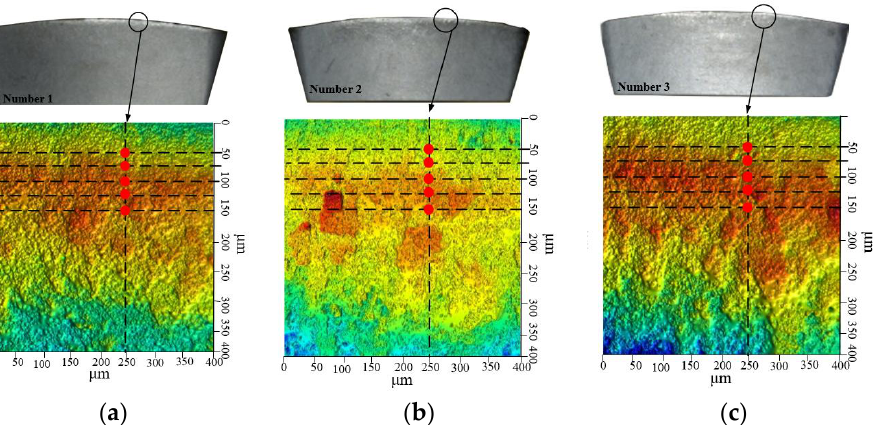
Figure 14. Experimental results of the wear profile of three blades of scheme 2: ( a ) tooth 1; ( b ) tooth 2; ( c ) tooth 3.